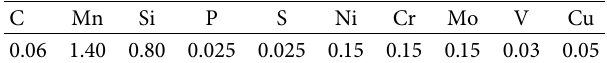
Figure 1: Geometry and dimensions (unit: mm). (a) Specimen. (b) Plane view. (c) Groove details. Table 2: Chemical composition of ER50-6 welding wire (mass fraction,